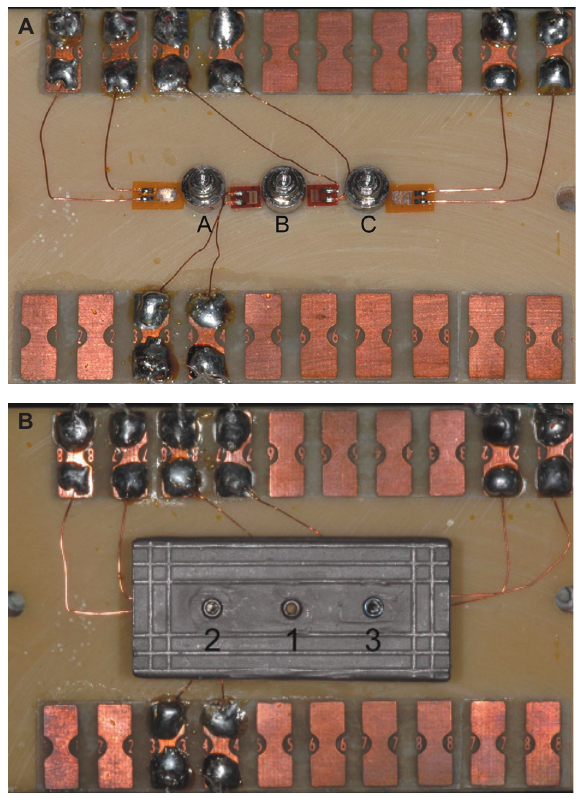
Figure 5- Strain gauges locations and the